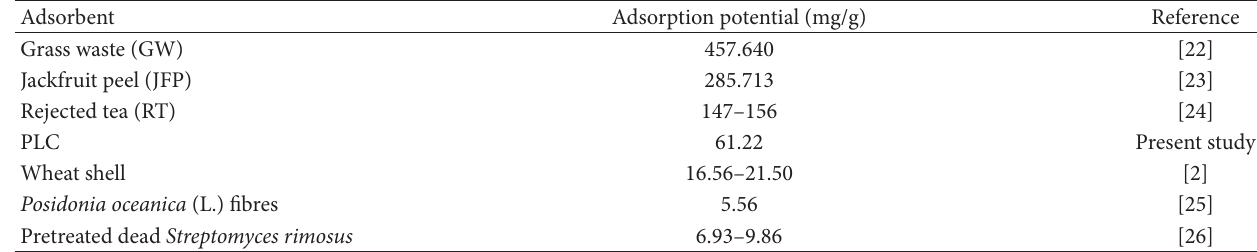
T 4: Comparison of adsorption capacities of low cost